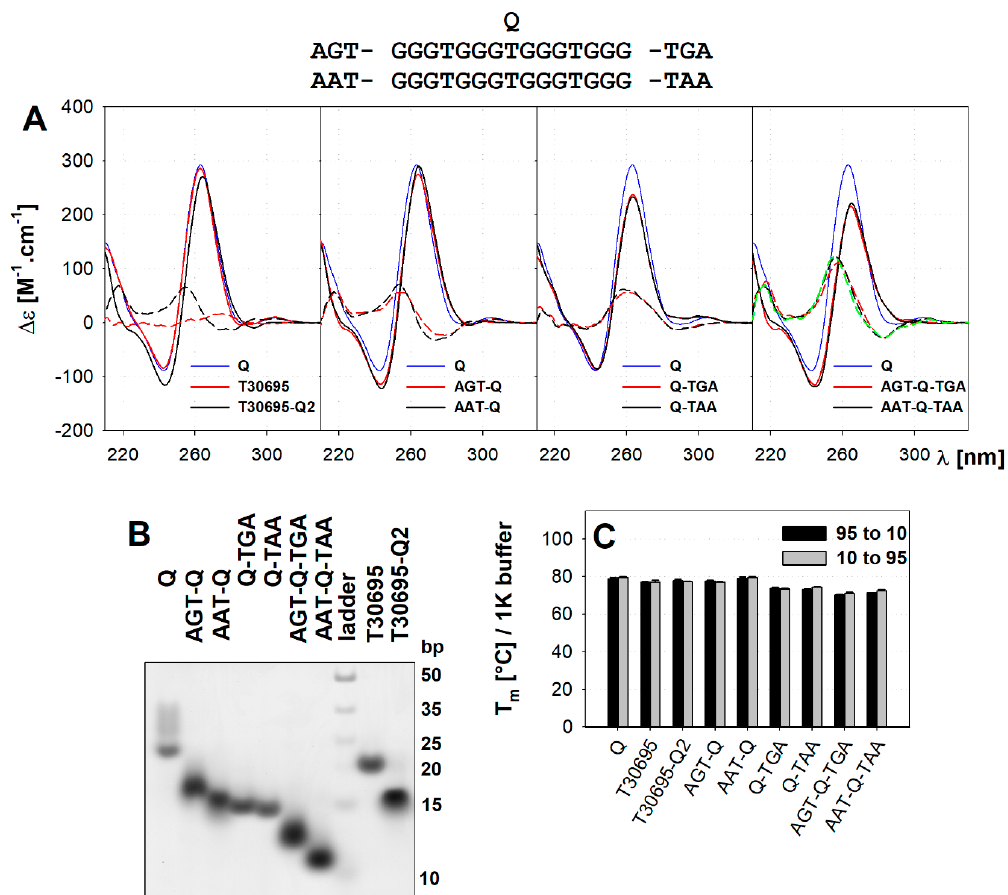
Figure 1. Model parallel quadruplexes with/without terminal overhangs: ( A ) CD spectra measured in 100K buffer at 20 °C; solid curves represent CD spectra, dashed curves represent difference to the Q spectrum; green line represents sum of differences of left and right overhang for AAT…TAA variant. ( B ) Native PAGE performed in 100K buffer at 20 °C. ( C ) Melting temperatures measured in 1K buffer, pH 7.